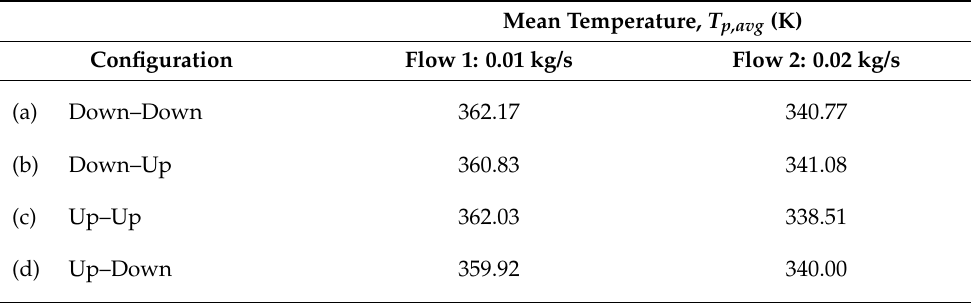
Table 5. Mean temperatures in the flat plate receiver of the U-shape double-pass